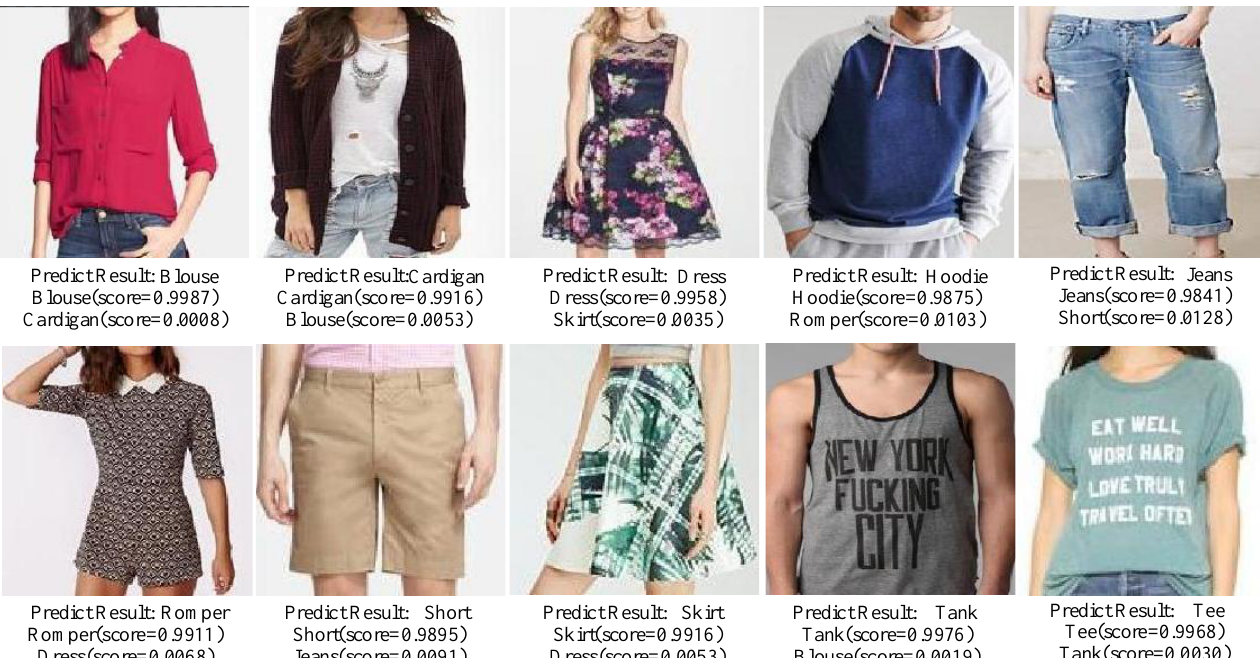
Figure 11. The effectiveness of the EnCaps network in detecting garment